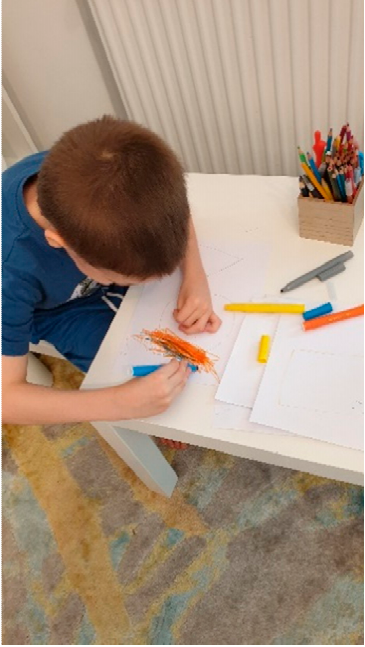
Figure 14. Child Figure 14. Child drawing.